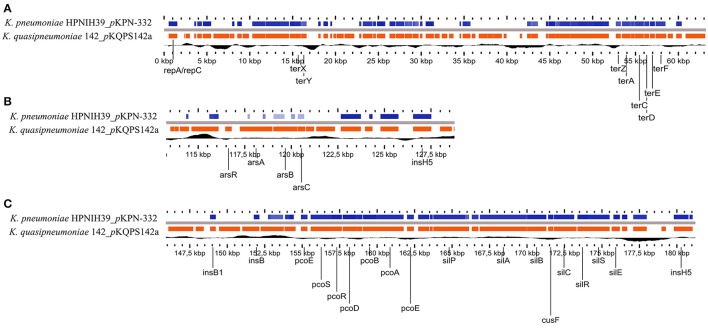
Genomic comparison between the plasmid pKQPS142a of Kqps142 and plasmid pKPN-332 of K. pneumoniae KPNIH39 performed by Gview program, using BlastN (>70% identity and E-values < 10−5). Black line represents GC content. (A) region of ter loci; (B) arsenical operon, and (C) copper-resistance operon and silver resistance genes.